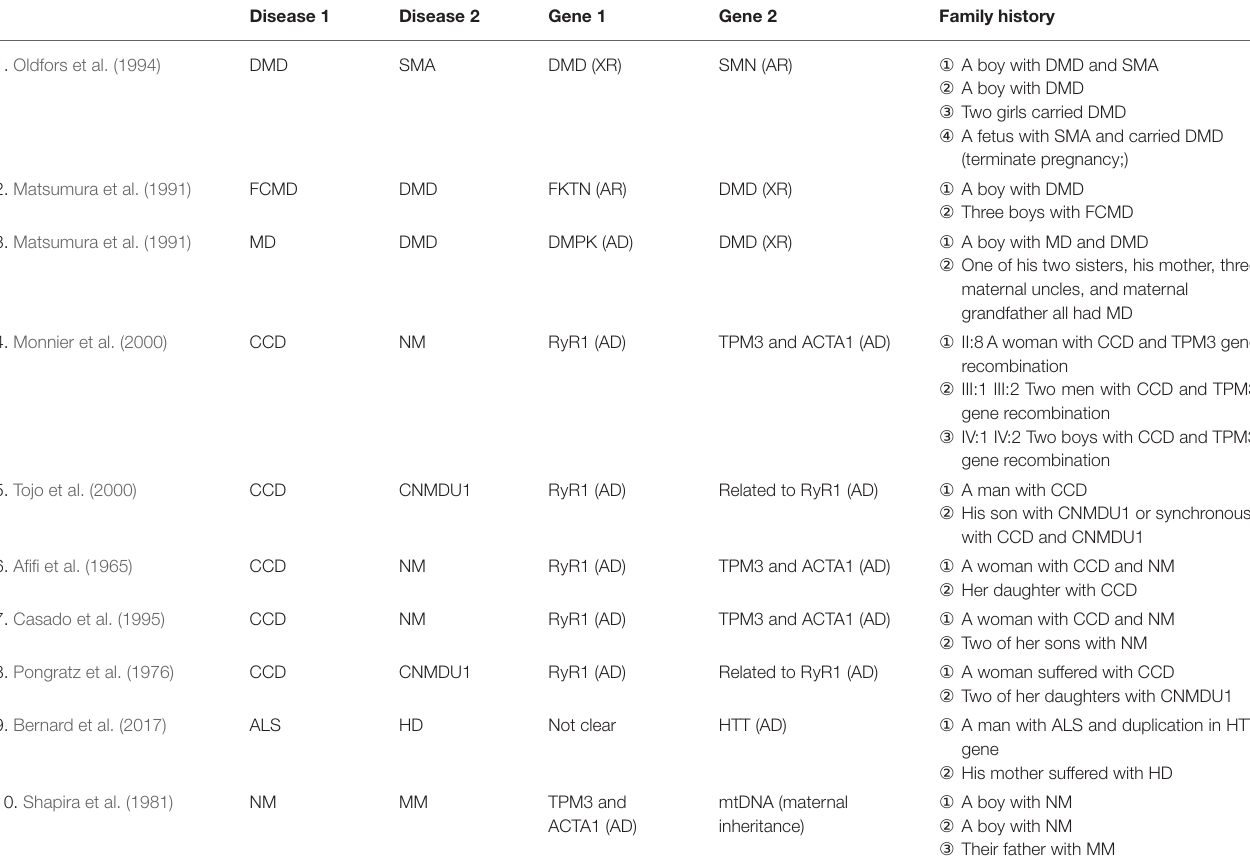
TABLE 1 | Cases with co-occurrence of two genetic diseases in various